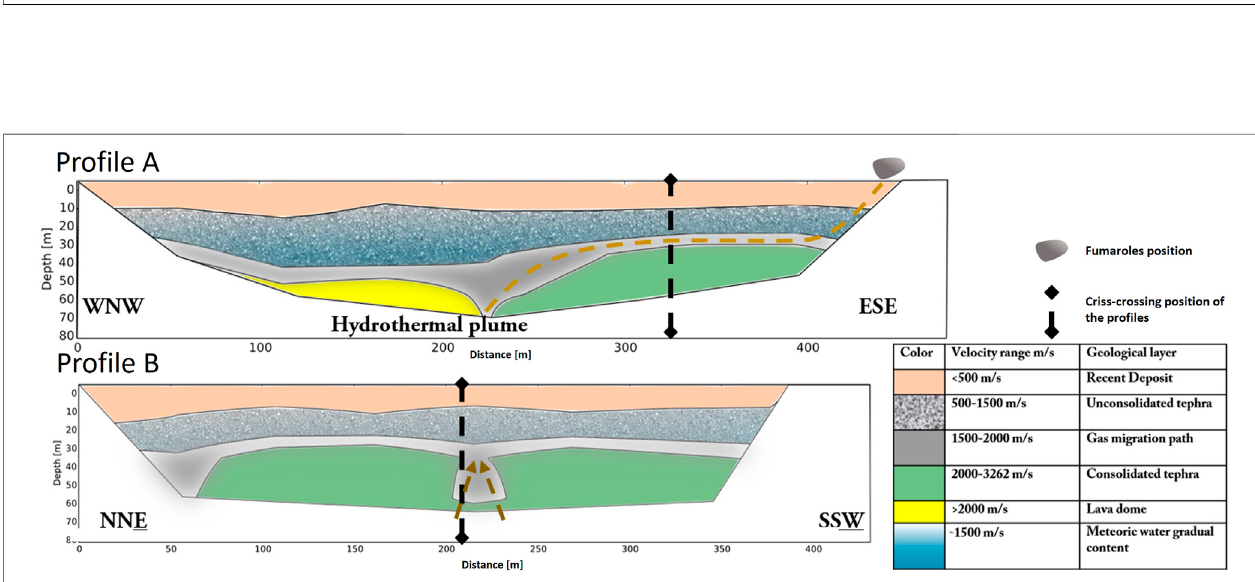
FIGURE 1 | Solfatara Volcano location and RICEN experiment acquisition layout. In the embedded upper box we represent the position of the Campi Flegrei caldera (CFc) concerning Italy on the left side; the border of the two calderas and crater rims of the CFc is on the right side. In the main box, is the Solfatara Volcano with the arrays deployments, the Fangaia area, and the main fumaroles position. The symbol legend is in the lower box. The maps have been obtained with Google Earth.